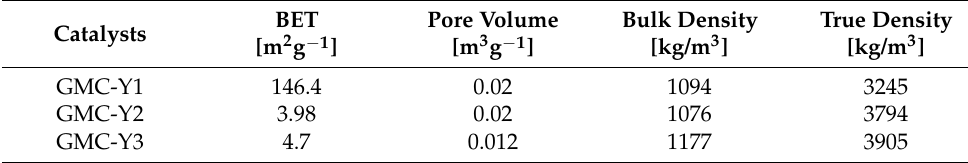
Table A3. Physical properties of the GMC-Y1, 2, 3